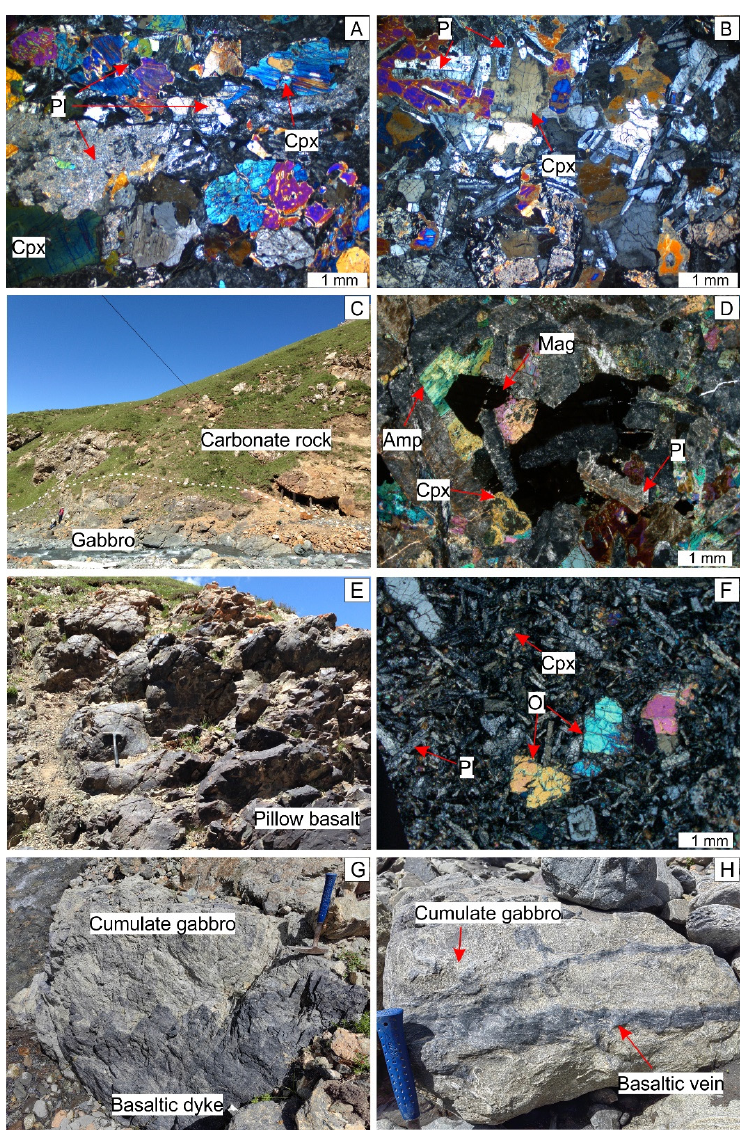
Figure 3. Field photos and photomicrographs of mafic rocks in the study area. ( A ) Cumulate texture of 13HC ‐ 025 under cross ‐ polarized light (XPL) view with plagioclase as the cumulate mineral and anhedral clinopyroxene as the intercumulus mineral. ( B ) The ophitic texture of diabase 13HC ‐ 015 under XPL view. ( C ) The isotropic gabbro 14HC ‐ 005 ‐ 1 intrudes into carbonate rock. ( D ) The iso ‐ tropic gabbro 14HC ‐ 005 ‐ 1 under XPL view with plagioclase and clinopyroxene as the main mineral phase. Several clinopyroxene crystals are replaced by amphibole. ( E ) The pillow basalt 14HC ‐ 003 with pillows ranging from 20 to 50 cm in diameter. ( F ) The pillow basalt 14HC ‐ 003 under XPL view with olivine as phenocryst and plagioclase and glass in the groundmass. ( G ) Basaltic magma in ‐ truded into cumulate gabbros showing as dykes. ( H ) Basaltic magma intruded into cumulate gabbro showing as veins.